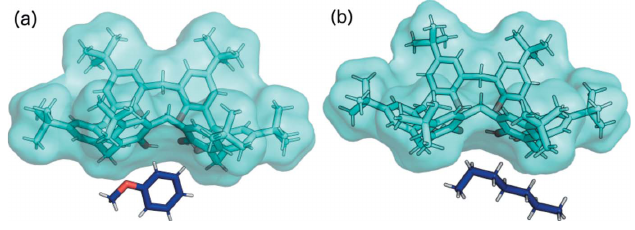
Figure 8 The asymmetric units of TBC6 solvated with ( a ) anisole ( 9 ) and ( b ) n -heptane ( 10 ). Disorder has been removed for